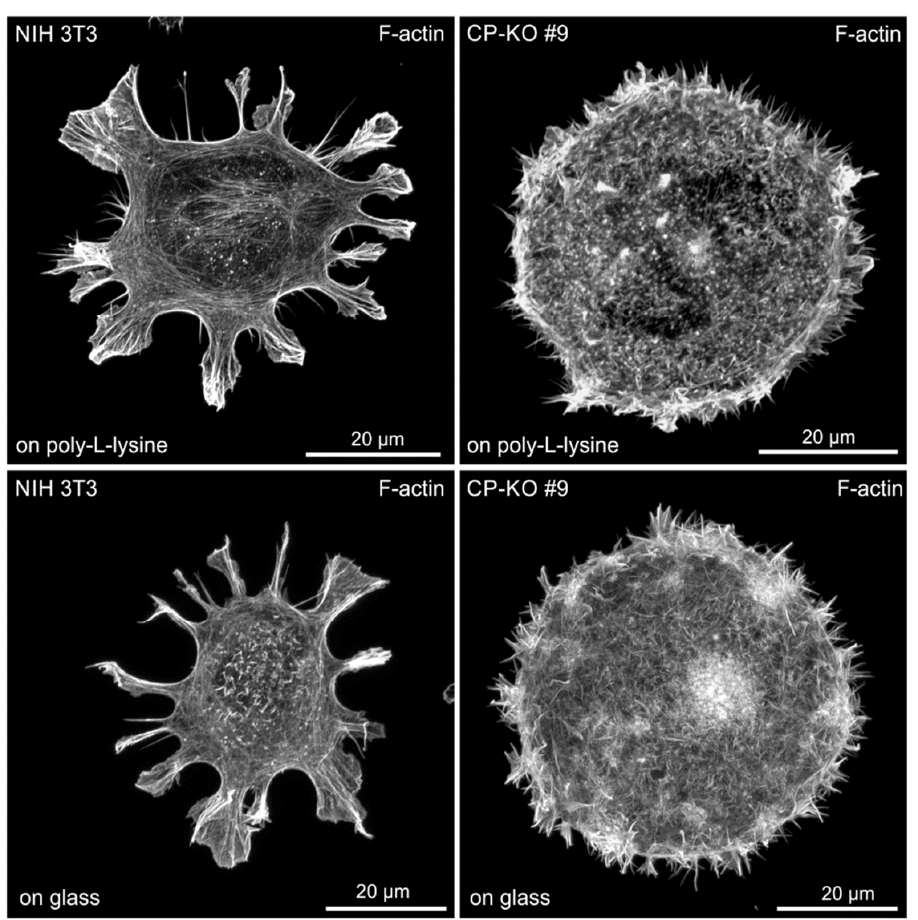
Figure 4. CP-deficient NIH 3T3 fibroblasts form numerous filopodia on poorly adhesive substrates. Representative images of NIH 3T3 wild-type and derived CP-KO mutant cells seeded on poly-L-lysine- coated glass ( top ) or directly on glass ( bottom ) and stained for the F-actin cytoskeleton with fluorescent phalloidin. Brightest point projection of 3D reconstructions from Airyscan confocal sections are